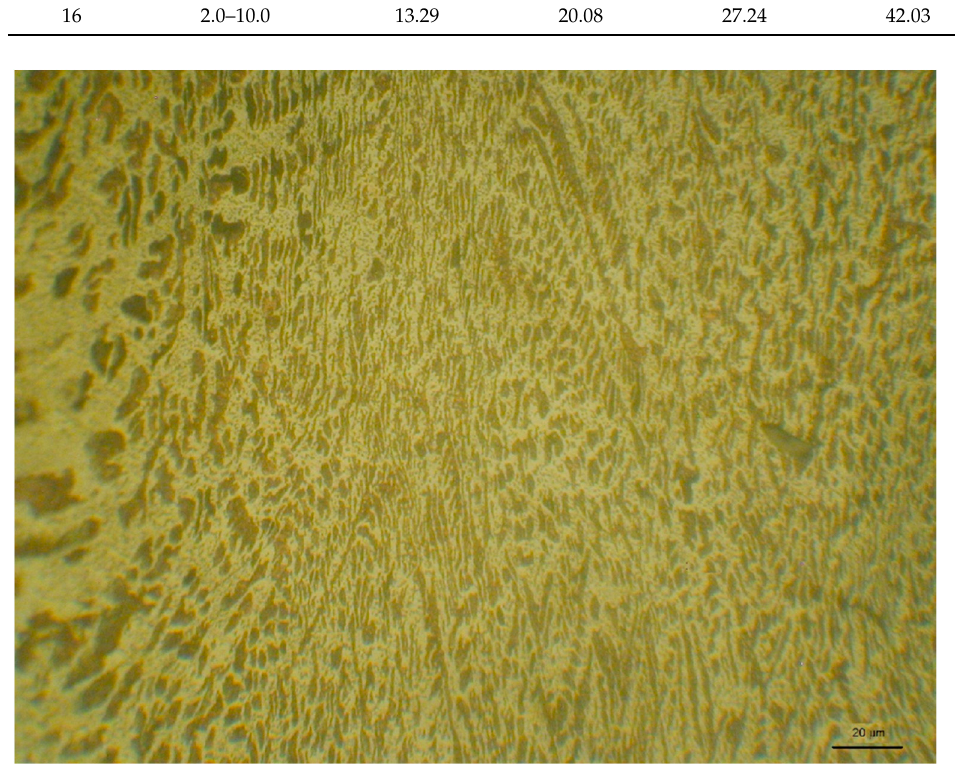
Figure 6. Microstructure of sample No. 16. Table 3. The relationship between the diameter of the grain and the diagonal of the indentation. Sample No.